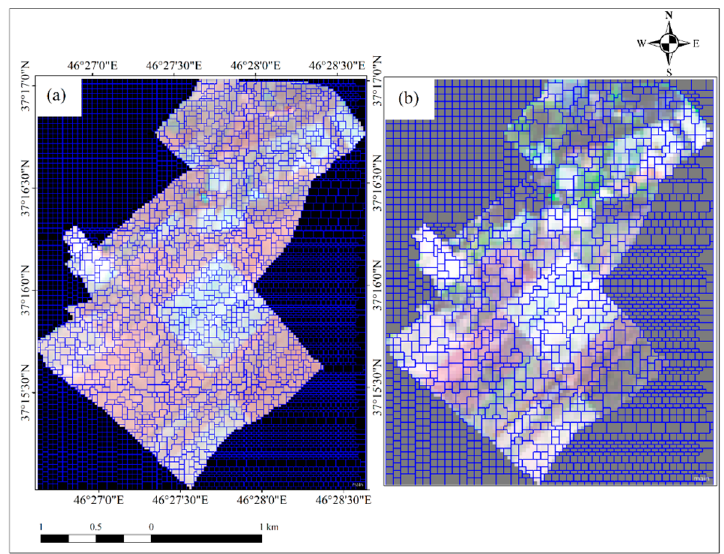
Figure 3. Multi-resolution image segmentation: ( a ) Sentinel-2A and ( b ) Landsat-8.